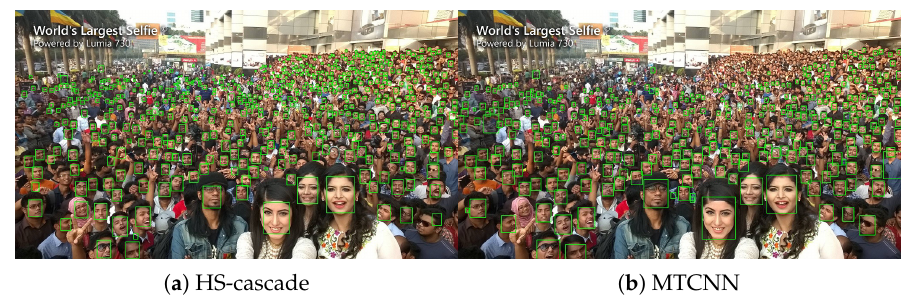
Figure 13. Comparison between HS-cascade and MTCNN (Example 1).